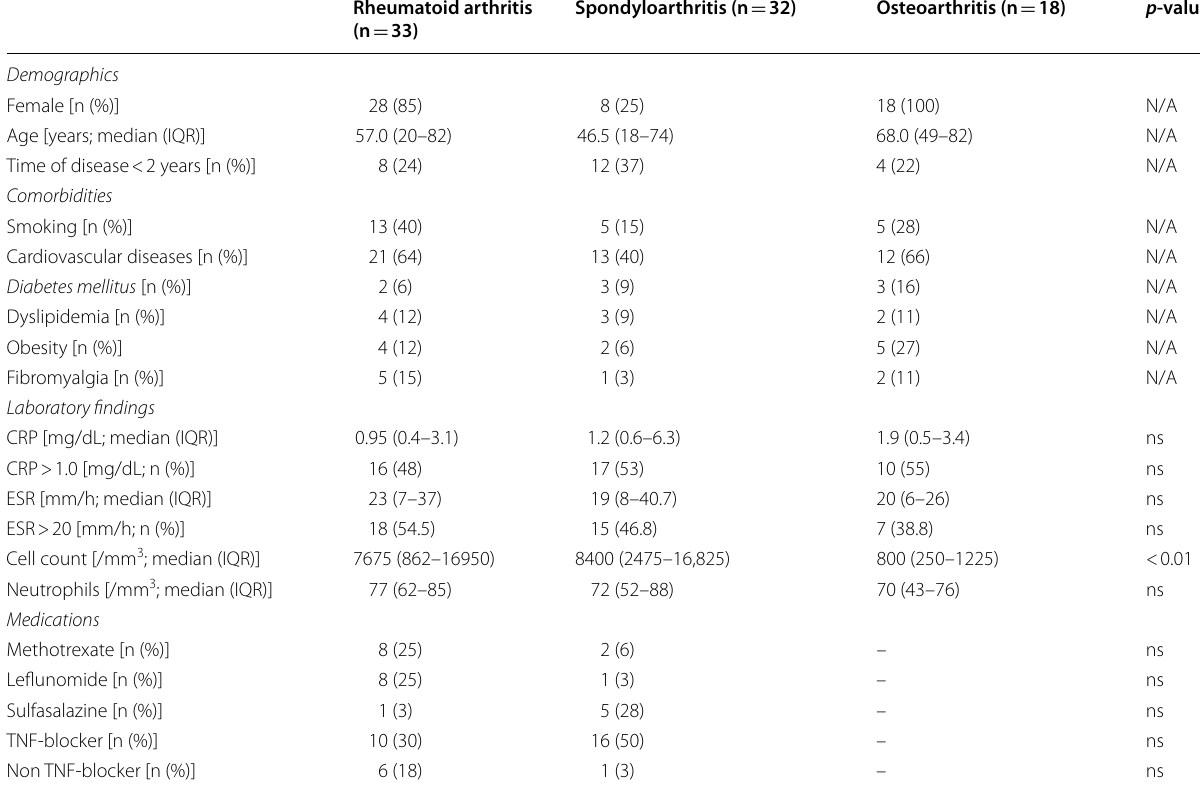
IQR interquartile range, CRP C-reactive protein, ESR Erythrocyte sedimentation rate